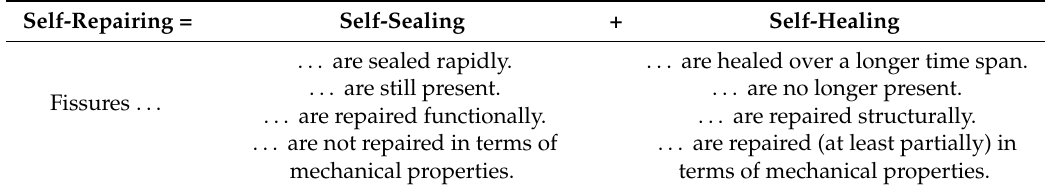
Table 1. Characteristics of self-repairing, self-sealing and self-healing valid for biological and technical materials (adapted from